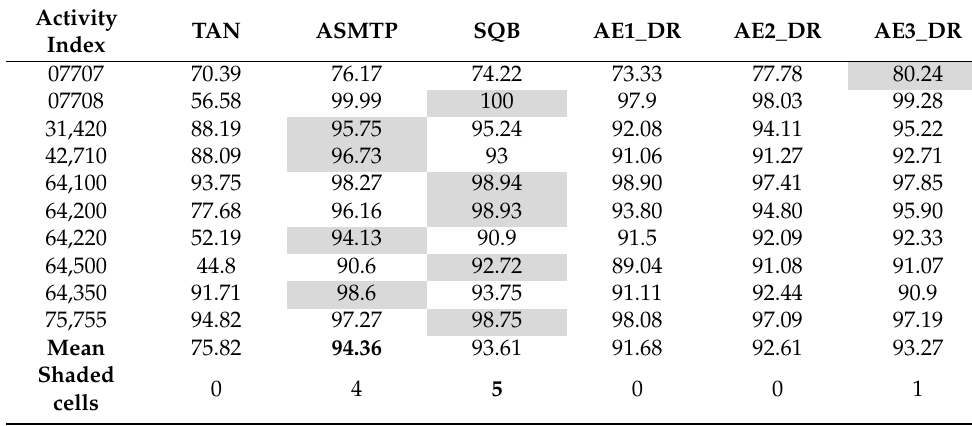
Table 7. The Retrieval results of top 5% for MDDR-DS2 dataset.